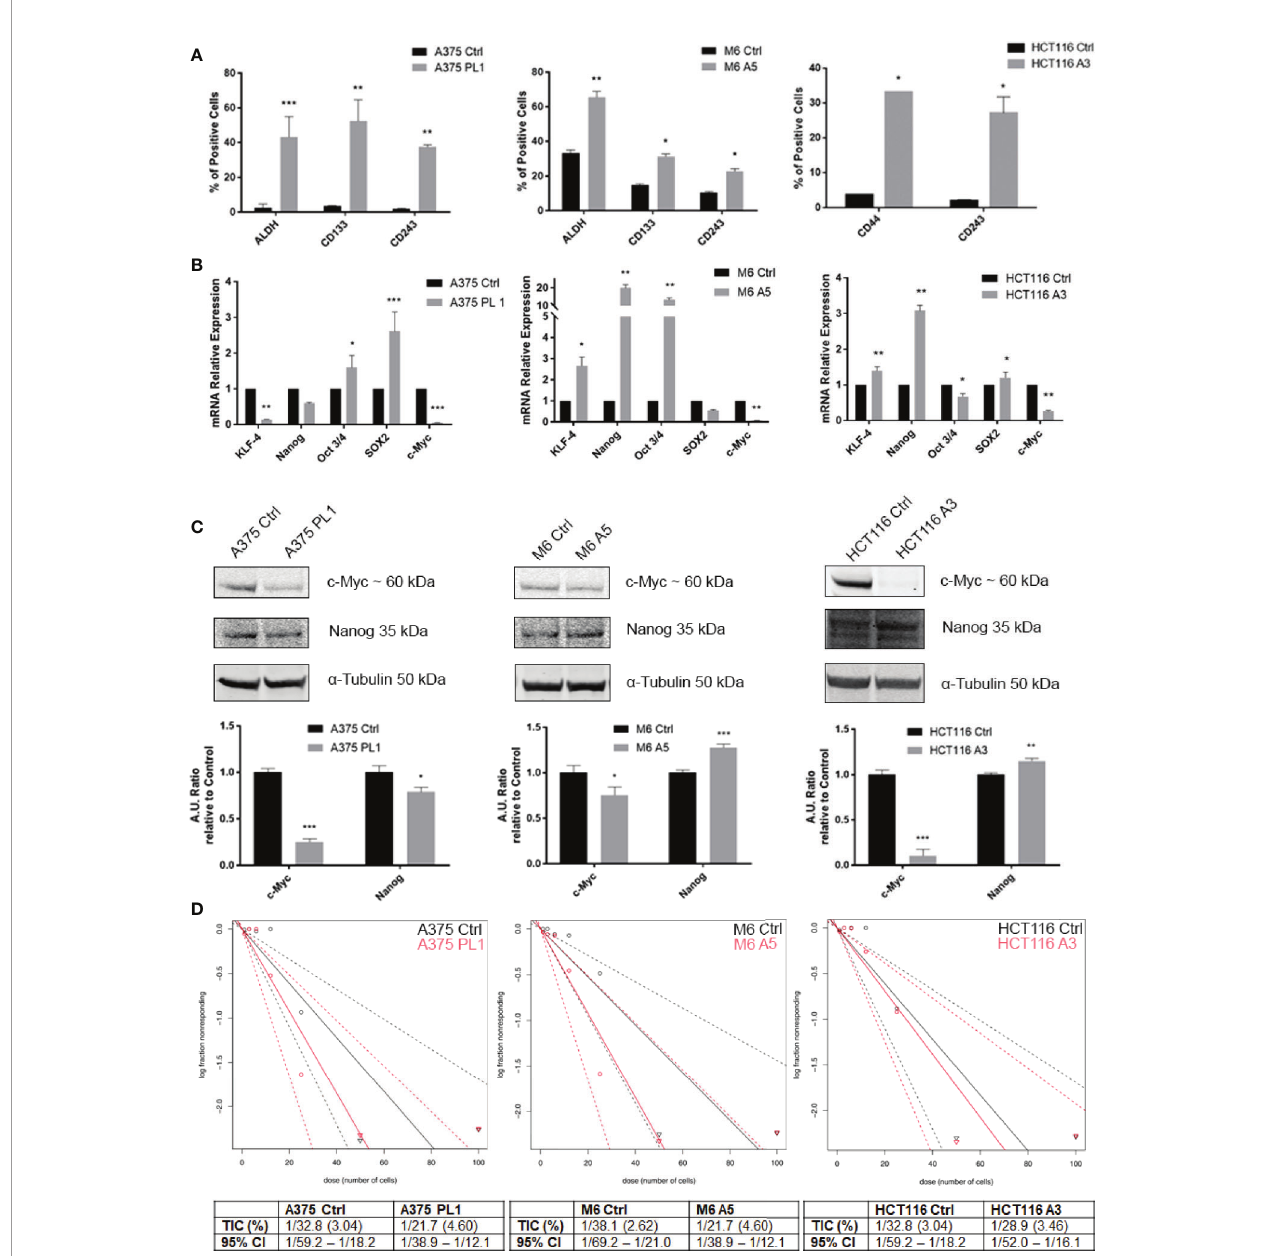
FIGURE 3 | (A) Melanoma uPAR KO cells were tested for ALDHA1 and CD133 while colon carcinoma uPAR KO cells were tested for CD44 by FACS analysis. CD243 expression was evaluated on all the three uPAR KO cell lines (n = 3). (B) Total RNA isolated using Tri Reagent was subjected to RT – PCR and qPCR was performed (n = 3). (C) Whole-cell lysates were analyzed by Western Blot for c-Myc, and Nanog expression and a -Tubulin was used as a loading control (n = 3). (D) Limiting dilution sphere assay of uPAR KO and control cells. ELDA analysis plot (upper) and relative table reporting the TIC percentage (lower) (n = 5). Values are mean ± SD; *p <0.01, **p <0.001, ***p <0.0001 (Student ’ s